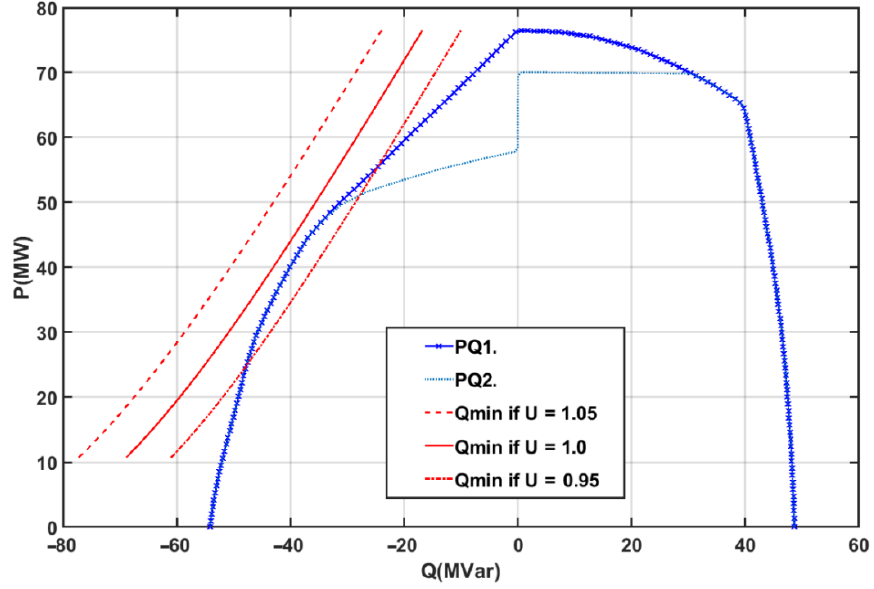
Figure 6. P-Q capability diagram of Novosibirsk HPP hydroelectric generator.